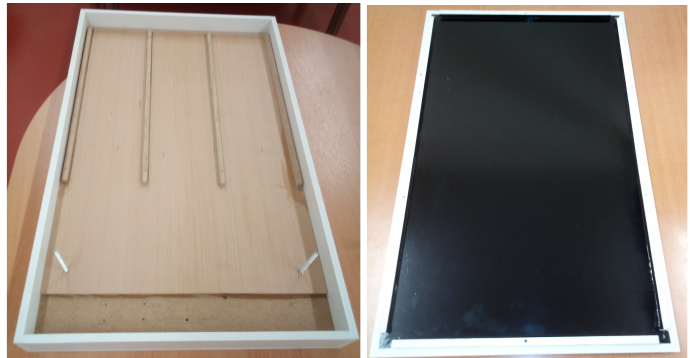
Figure 2. On the left photo the PVC box with the MDF support structure inside is shown. The long thin slats shown are glued on the MDF wood and the scintillation tiles are fitted in between. On the right the lid is shown with the black adhesive sheet on the inside for light